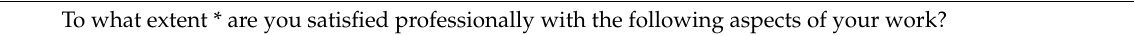
Table 4. Work effort, with subsequent professional satisfaction and experienced proficiency in COVID-ICU Health care professionals, mean (SD), N = 484. RNs Physicians Leaders (n = 392) (n = 43) (n = 49)